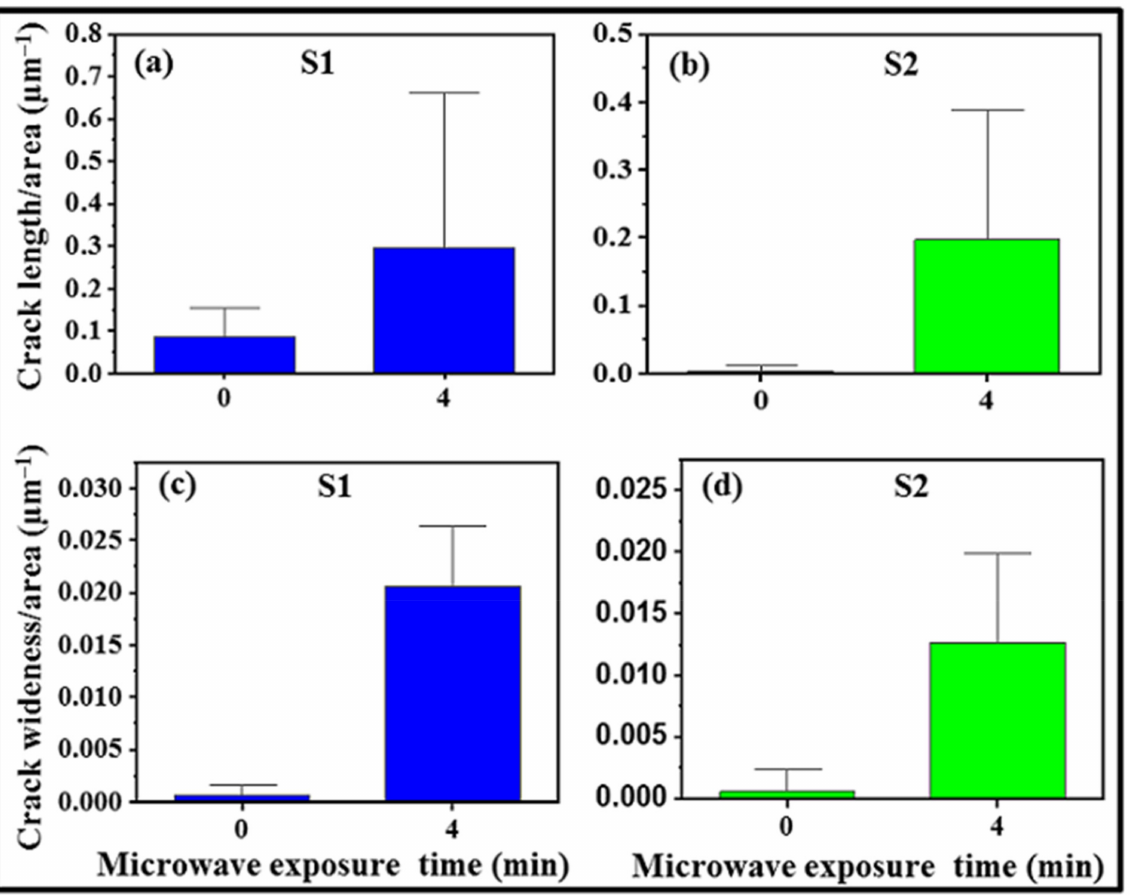
Figure 8. ( a , b ) Crack length per unit area of the untreated and microwave-treated S1 and S2. ( c , d ) Crack wideness per unit area of the untreated and microwave-treated S1 and S2